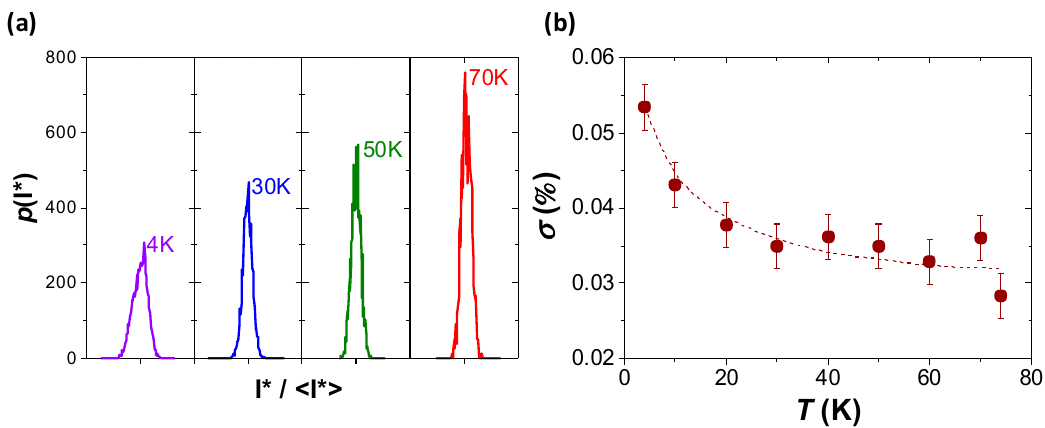
Figure 6. ( a ) Histograms of probability density of the switching current for a 300-nm-wide nanowire, p(I* ), as a function of I* , normalized to the average value < I* >. The X-axis extends from I*/<I*> = 0.996 to 1.004 in all of the histograms measured at different temperatures. ( b ) Temperature dependence of the standard deviation obtained from the p ( I* ) histograms.